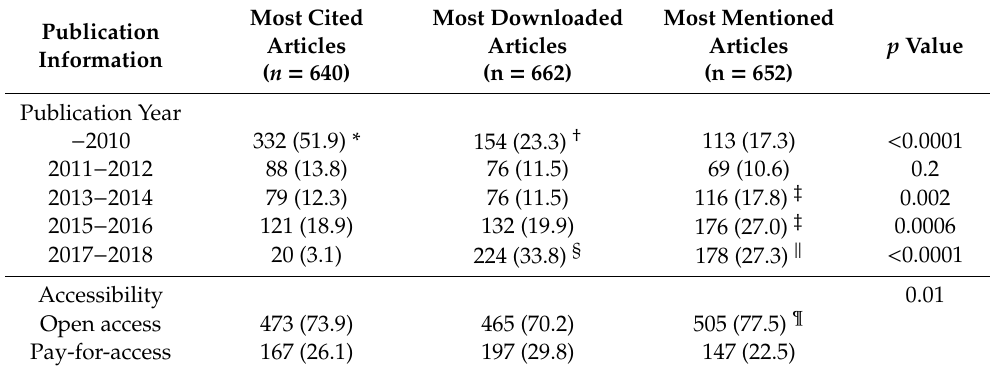
Table 4. Publication year and accessibility of the most cited, most downloaded, and most mentioned articles published in general medical